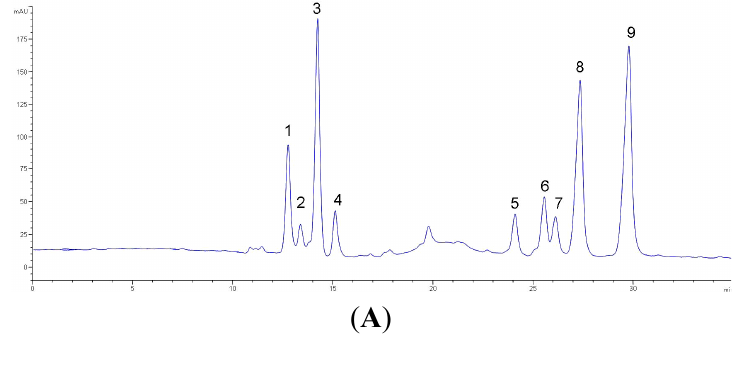
Figure 2. The HPLC chromatogram ( A ) and LC-ESI-MS/MS spectra of PRS ( B